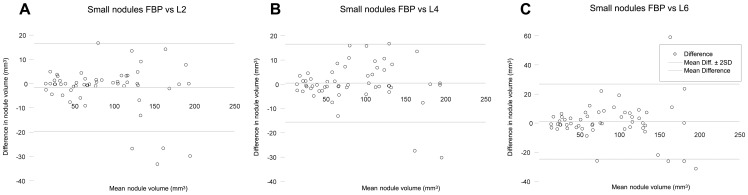
Agreement of small pulmonary nodule measurements.Bland-Altman plots of CT measured nodule volume at filtered back projection (FBP) and iterative reconstruction (iDose4 level 2 (A), 4 (B) and 6 (C)) for small nodules. The horizontal axis shows the mean value of the measured nodule volume with FBP and iterative reconstruction. The vertical axis shows the difference between the measured nodule volume with FBP and iterative reconstruction. FBP Filtered back projection; L2 Level 2; L4 Level 4; L6 Level 6.